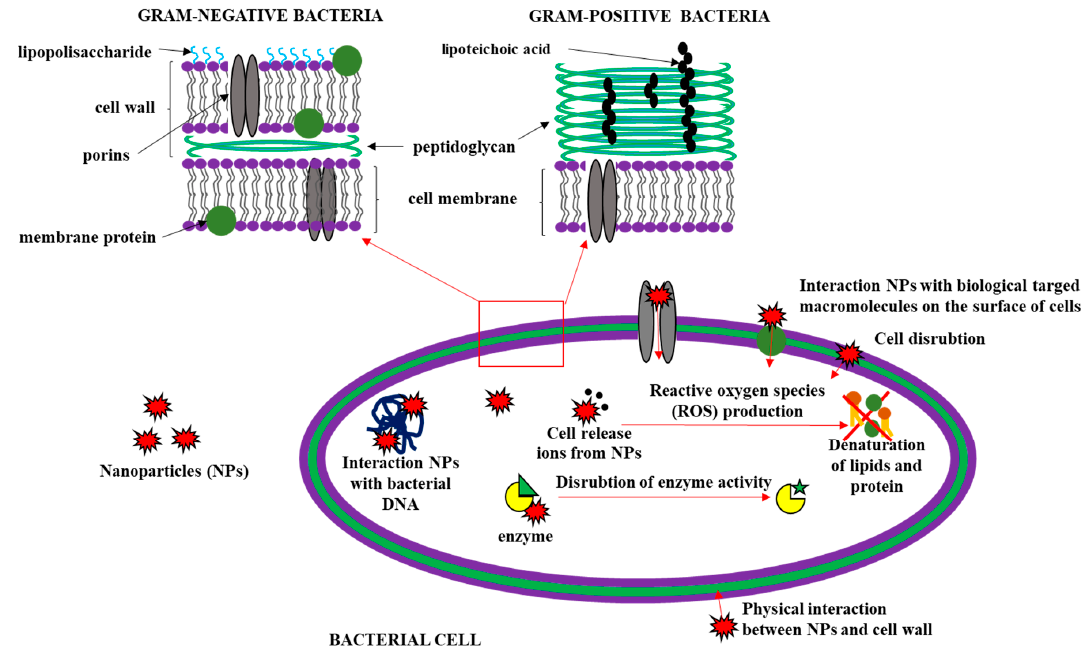
Figure 2. Potential mechanisms of antimicrobial activities of nanoparticles.